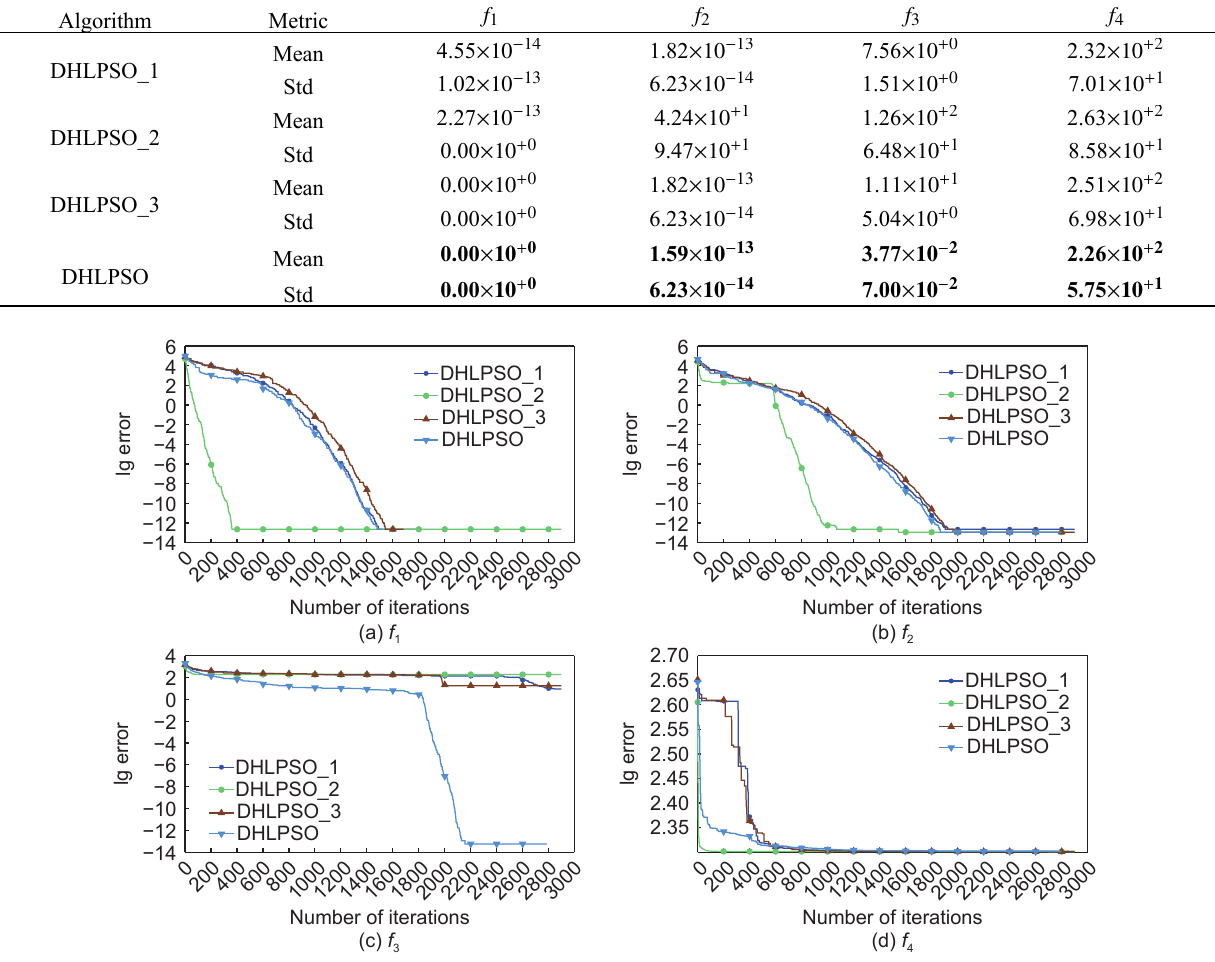
Table 2 Parameter settings of all the contrasted algorithms.